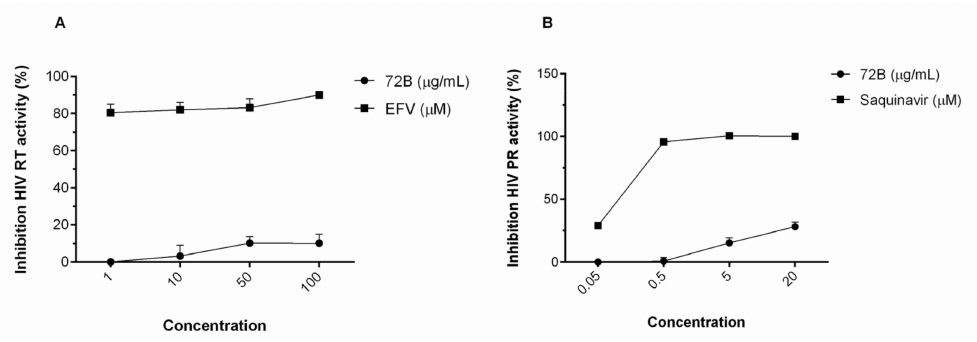
Figure 3. E ff ect of noncytotoxic concentrations of 72B on reverse transcriptase ( A ) or protease ( B ) activity. Efavirenz and saquinavir were employed as positive references in RT and PR assays, respectively. The inhibitory e ff ect of 72B is expressed as the percentage of activity of the treated enzymes relative to control w / o treatment. The results presented were obtained from three independent experiments. Data are mean ±